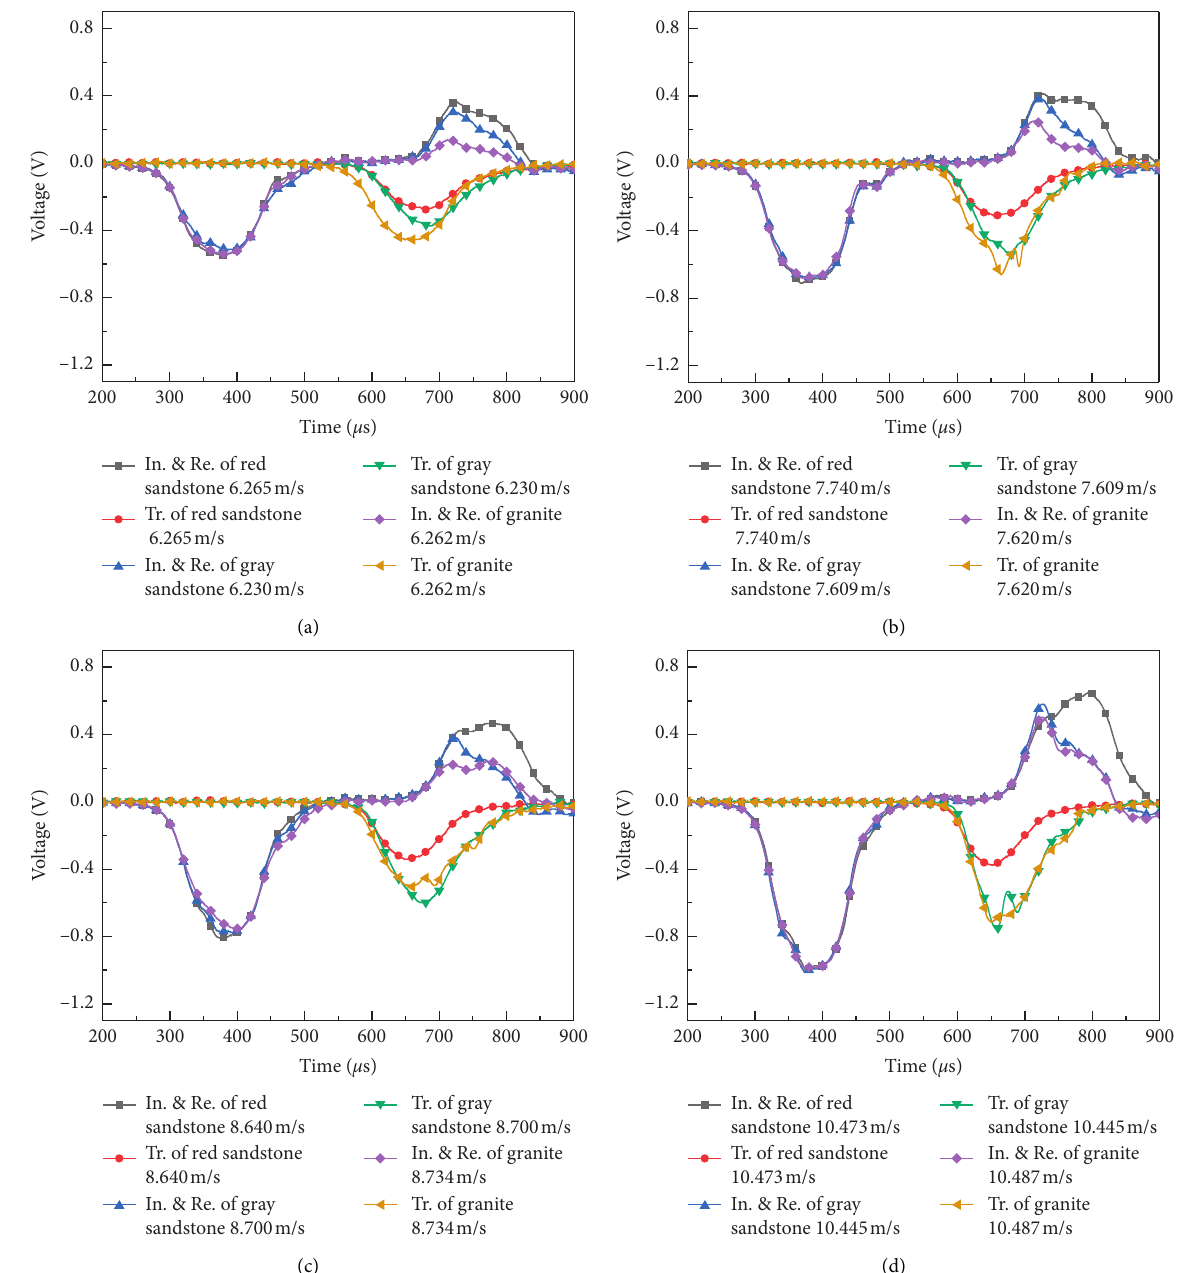
Figure 5: Waveform comparison chart of three kinds of rocks: (a) 6.25 m/s, (b) 7.65m/s, (c) 8.70m/s, and (d)